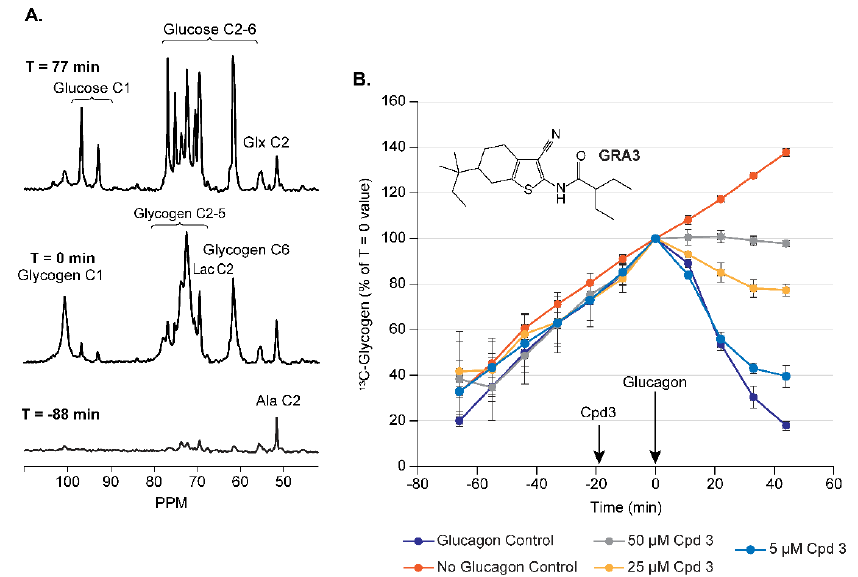
Figure 2. The development of a perfused liver assay for the assessment of glucagon receptor antagonists. ( A ) Sample 13 C NMR spectra over time from mouse livers harvested during the dark cycle metabolizing [2- 13 C] pyruvate. There is an increase and decrease in the [1- 13 C] glycogen NMR signal before and after the addition of 50 pM of glucagon, respectively, at T = 0 min. ( B ) The dose-dependent modulation of this process by a novel small molecule GRA3. Acquisition parameters for panel A as well as all other spectra in this review are as follows: 30° pulse, TR = 560 ms, NS = 800 averages, broadband GARP 1 H decoupling, 11 min/spectrum. Adapted from reference [13] .